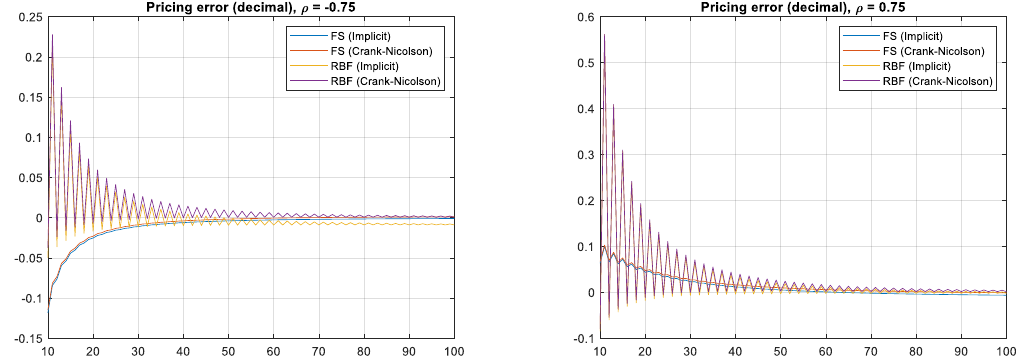
Figure 1. Pricing errors (in decimals) with respect to the number of partitions of space dimensions for ρ = − 0.75 ( Left ) and ρ = 0.75 ( Right ), respectively.